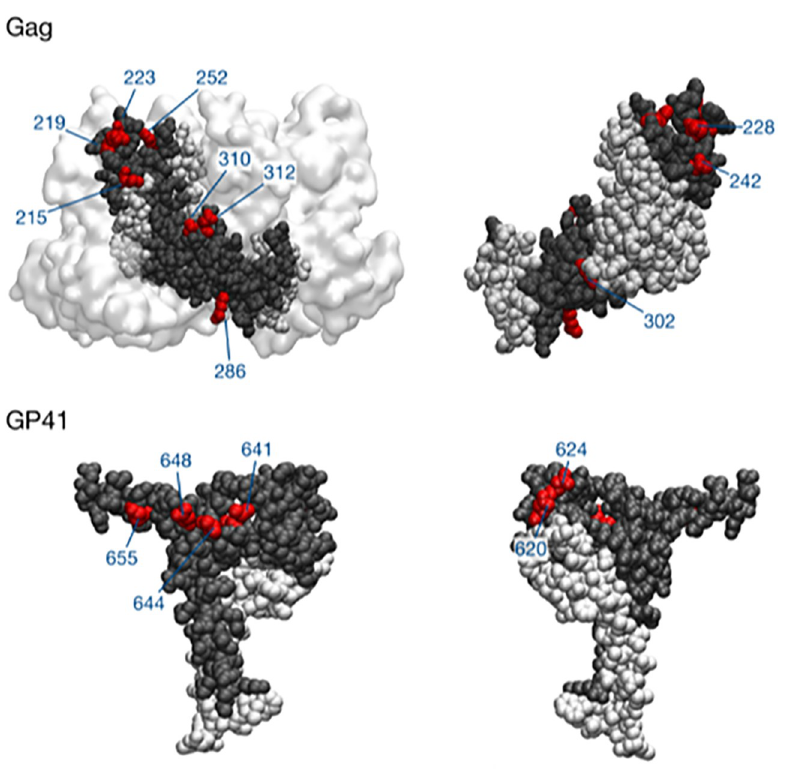
Fig 3. Locations of selected positions on the protein structures of p24 and gp41. Protein structures with pdb identities and 3J34 and 6NIJ were used to plot these figures [103,104].Parts of proteins that were covered by sequence data are shown in gray, with the remainder of the protein in white van der Waals representation. Amino acid positions identified by our analysis are shown in red. The gp41 structure does not show the entirety of the sequenced region, with amino acids at positions 670 and 674 also identified in our analysis, but not in the protein structure. Other nearby proteins are shown in white surface representation. Figures were created using the VMD software package [105].